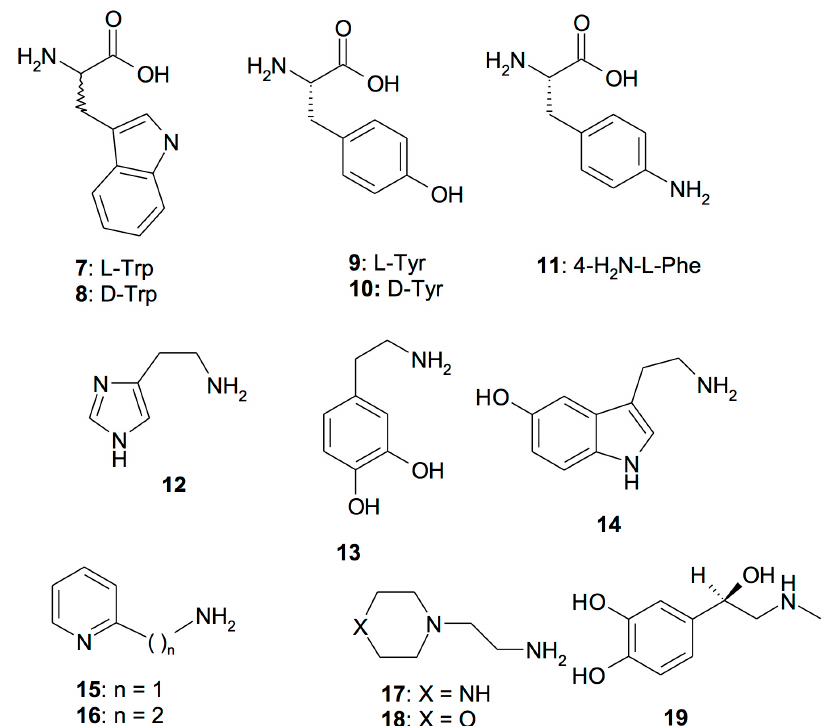
Figure 1. Amino acids 1 – 11 and amines 12 – 19 investigated as CruCA4 activators.